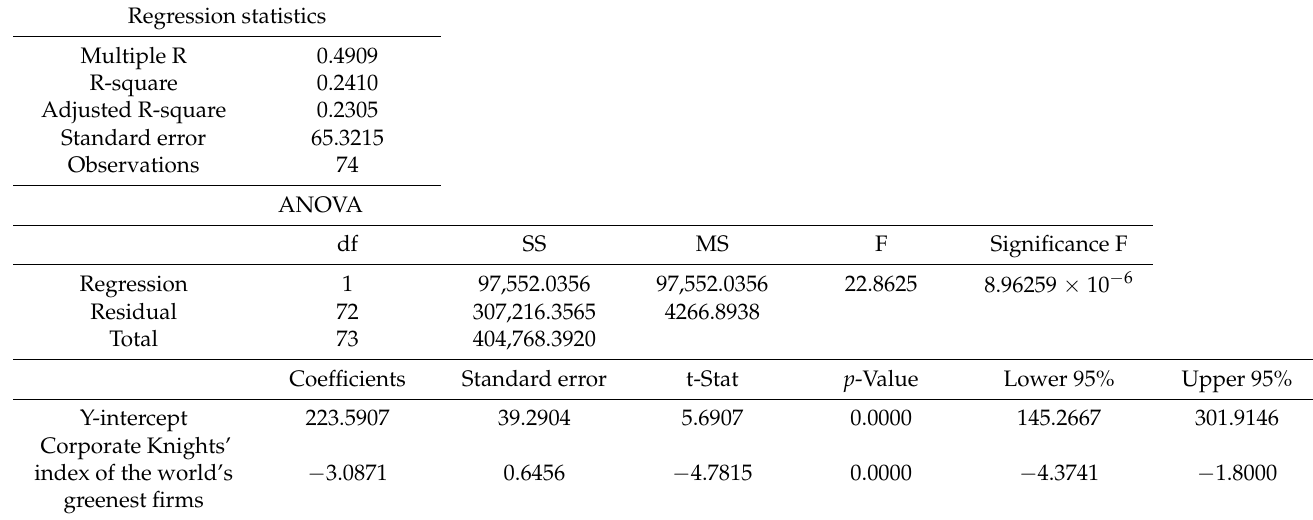
Table 6. Regression analysis of the dependence of the risk of reduction of market share on the level of corporate social responsibility in